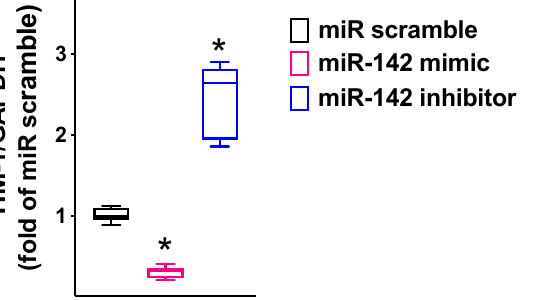
Figure 3. TIM ‐ 1 expression in hBMECs was reduced by miR ‐ 142 and increased by miR ‐ 142 inhibitor. TIM ‐ 1 mRNA levels were measured using RT ‐ qPCR in hBMECs transfected with miR ‐ 142 mimic, inhibitor, or scramble (negative control) for 48 h, normalizing to glyceraldehyde 3 ‐ phosphate dehy ‐ drogenase (GAPDH). All experiments were performed at least in triplicate; the box ‐ and ‐ whiskers graph shows the medians and the 5th–95th percentiles; * p < 0.01 vs. miR scramble. Sequences of oligonucleotide primers are reported in Table 1. Table 1. Oligonucleotide primer sequences.